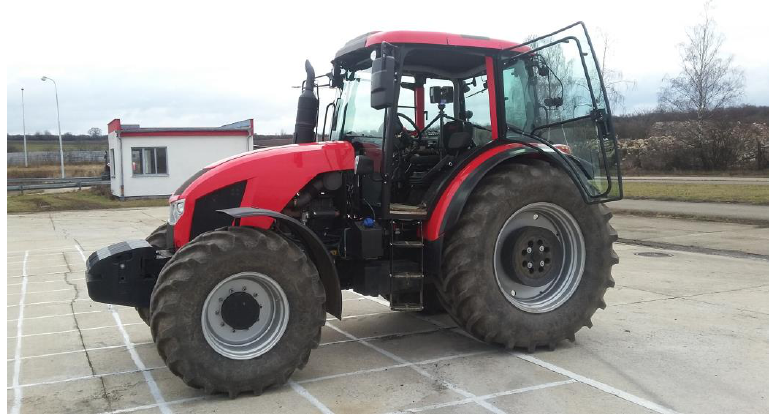
Figure 1. Agricultural tractor Model Zetor Forterra 150 HD, Brno, Czech Republic.